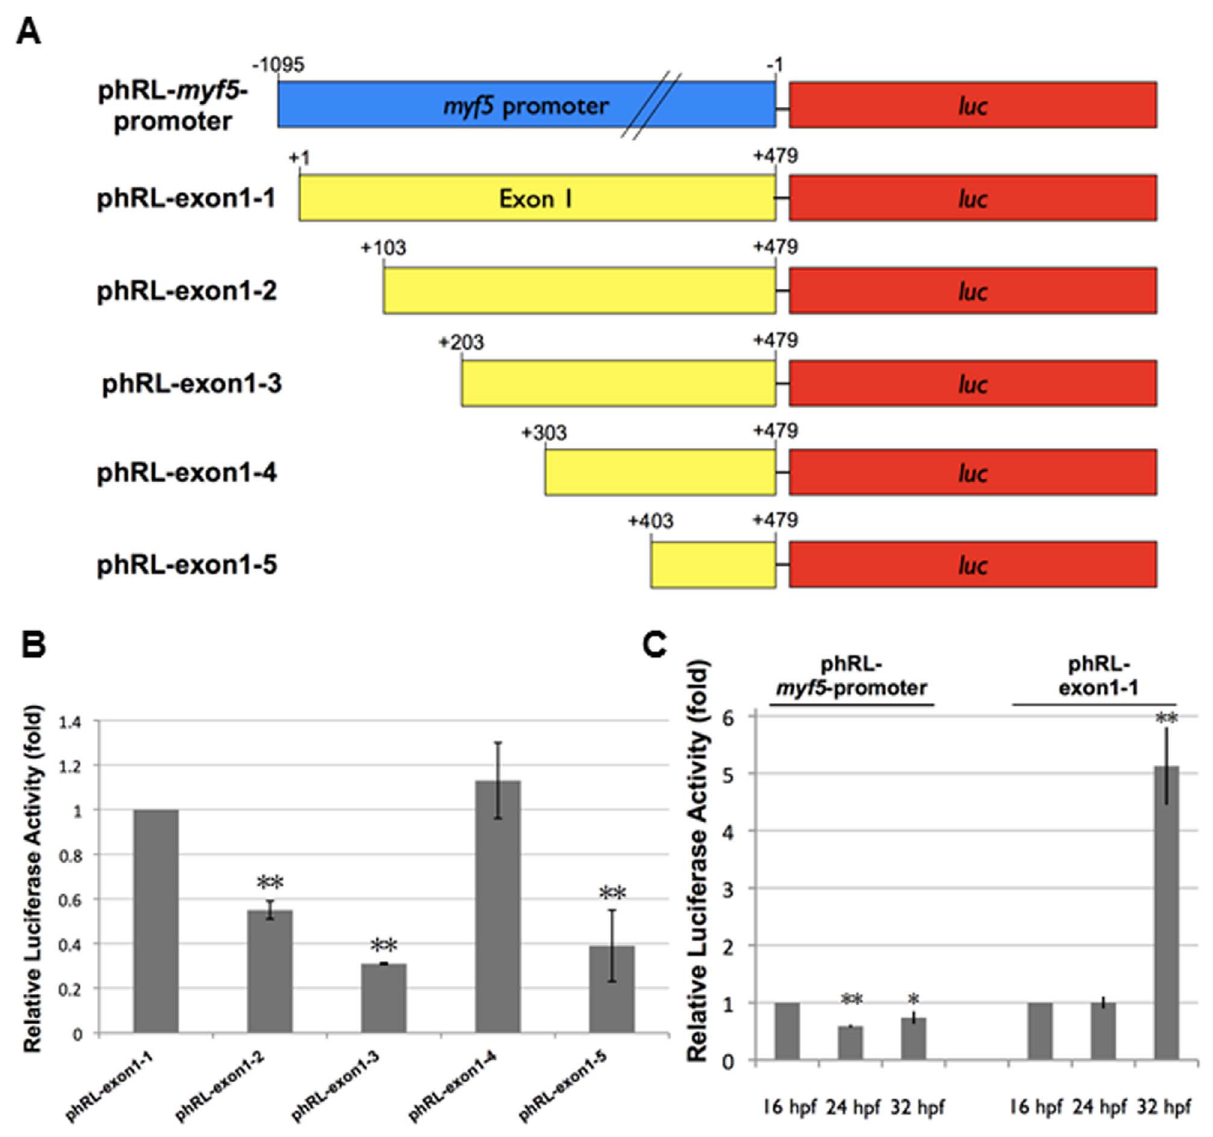
Figure 8. The proximal upstream cis -elements of miR-3906 are capable of controlling the transcription of miR-3906 . ( A ) The schematic diagrams of plasmid constructs having a 1.1 kb fragment upstream of myf5 gene and having various deletions of exon 1 of myf5 which are proximal upstream regulatory segments of miR-3906. ( B ) Luciferase activity assay in zebrafish embryos at 24 hpf. Plasmids phRL-exon1-1, phRL-exon1-2, phRL- exon1-3, phRL-exon1-4 and phRL-exon1-5 were co-injected individually with pGL3-TK, an internal control, into one-cell embryos. The luc expression of embryos injected with plasmid phRL-exon1-1 served as 1. The relative luc expression level of each combination was examined. ( C ) Luciferase activity assay in zebrafish embryos at 16, 24 and 32 hpf. Plasmids phRL- myf5 -promoter and phRL-exon1-1 were co-injected individually with pGL3-TK, an internal control, into one-cell embryos. The luc expression of each plasmid at 16 hpf served as 1. The relative luc expression levels of phRL- myf5 - promoter and phRL-exon1-1 at 24 and 32 hpf were examined. Data were presented as means 6 SD from three independent experiments (n=3). Student’s t -test was used to calculate the differences among data. *: indicates significant difference at P , 0.05 . **: indicates significant difference at P , 0.01